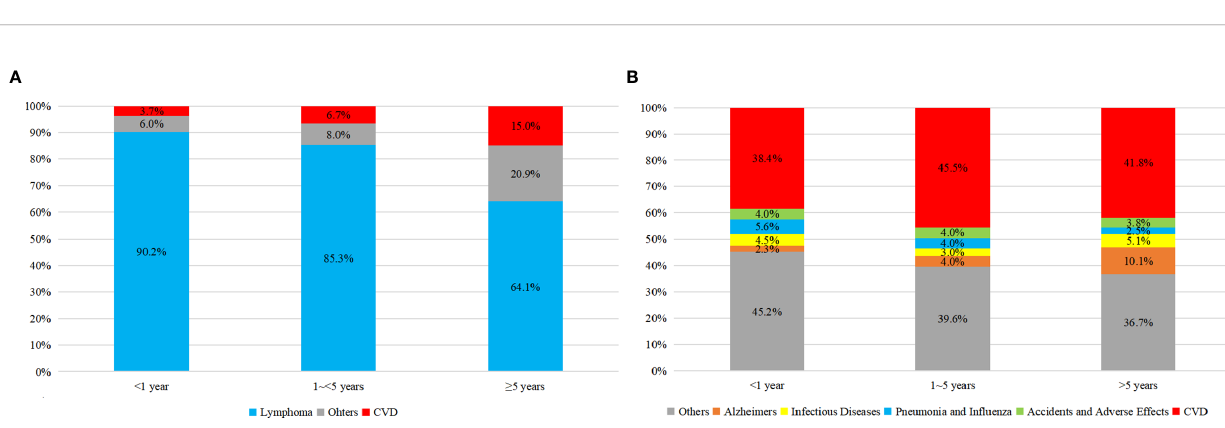
FIGURE 4 | Proportion of causes of death in PCNSLs by different survival time. (A) all causes of death, (B) non-cancer